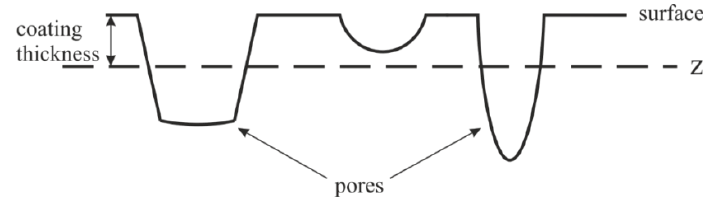
Figure 4. Schematic view of pore selection by the horizontal plane section.